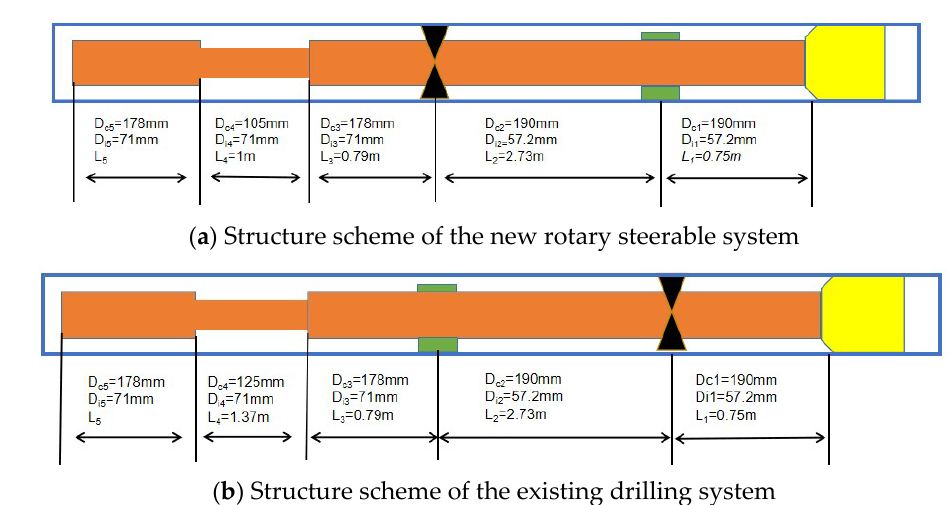
Figure 10. Structure comparison of rotary steerable drilling system.